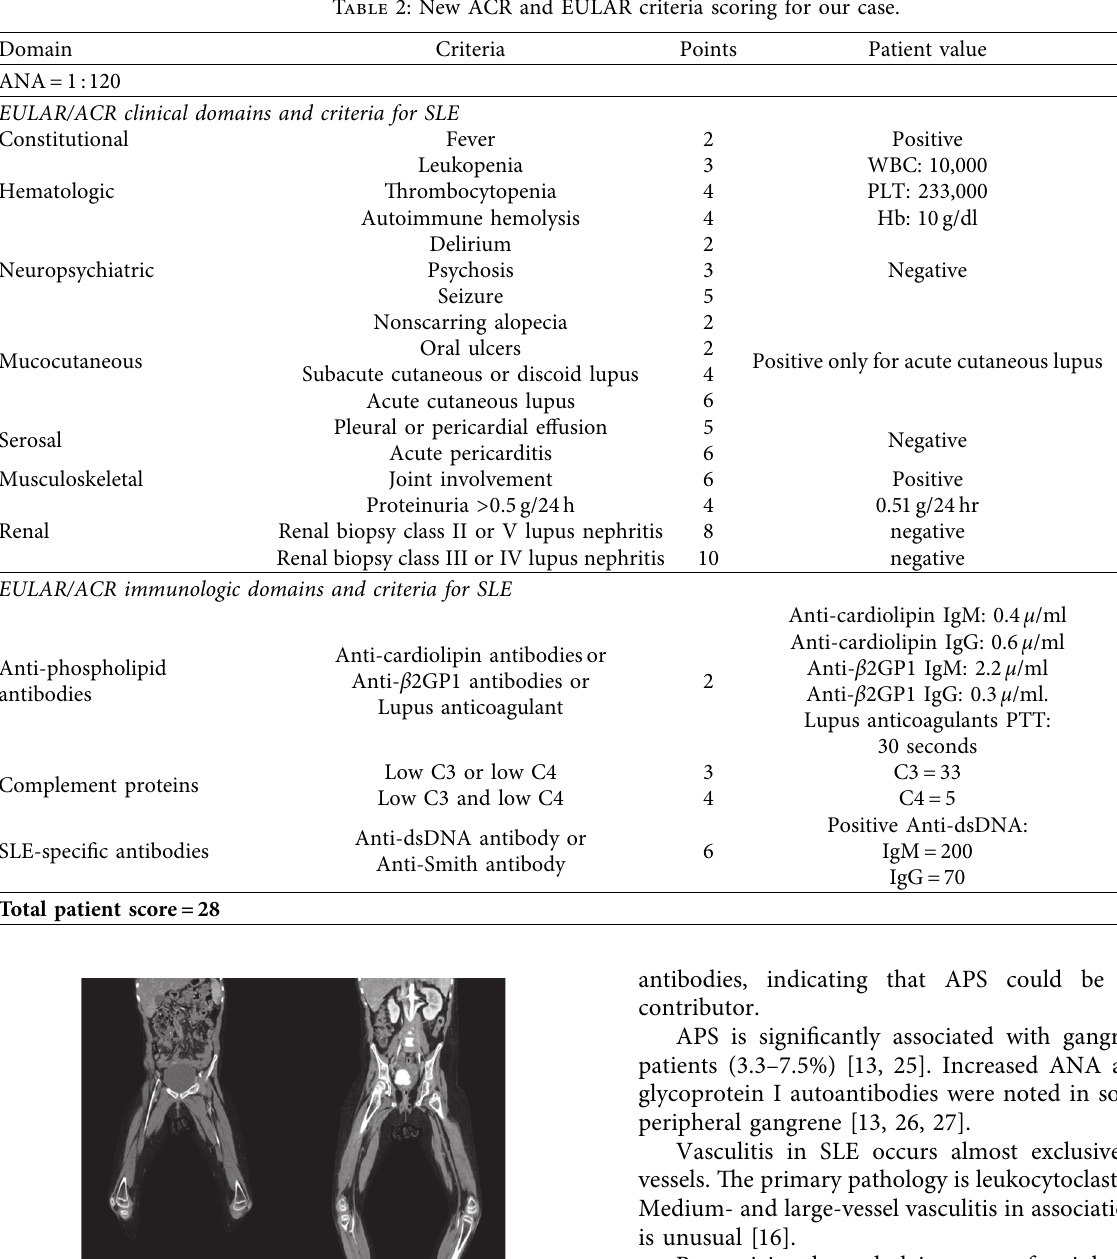
Table 2: New ACR and EULAR criteria scoring for our case.